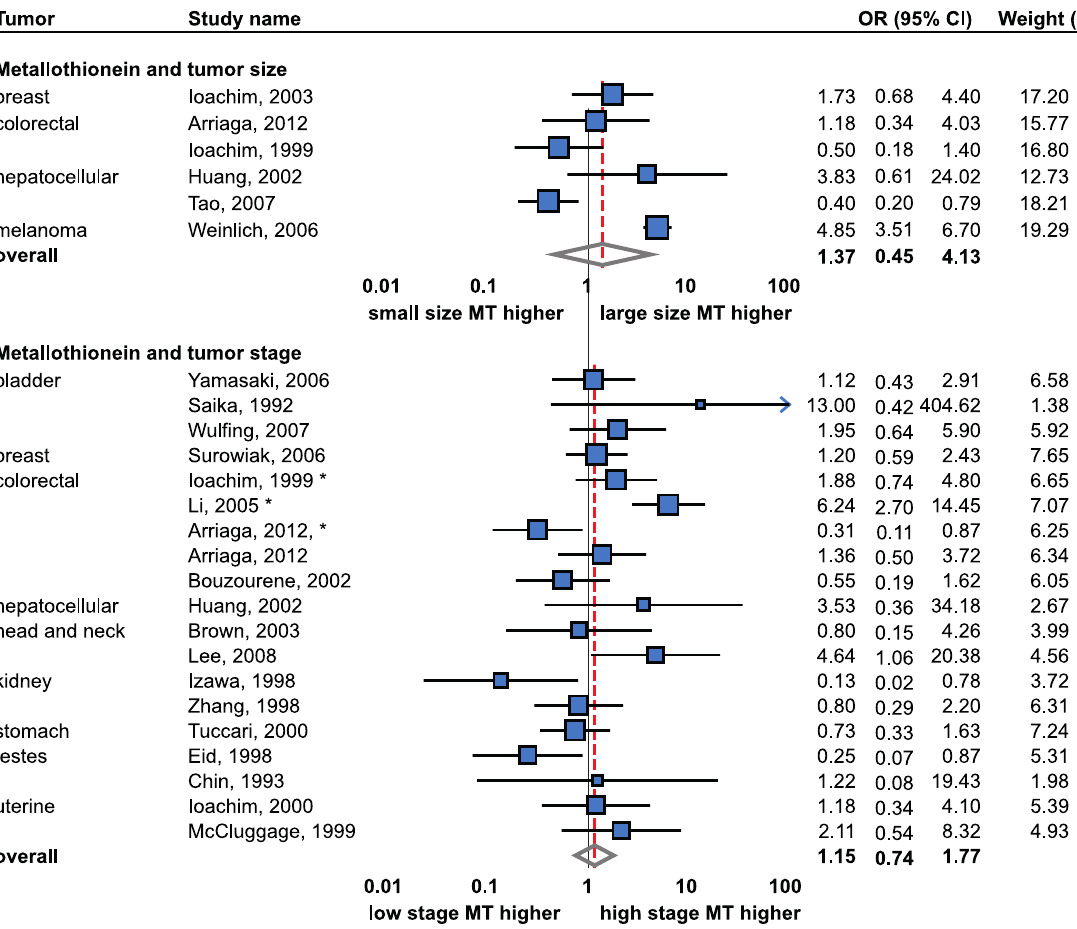
Figure 3. Forrest plot of studies reporting the association of metallothionein staining and tumor size and stage. Random effects model used for both outcomes, Relative weight of individual studies displayed in %. * indicates studies using Dukes staging system. For more detailed results see Table 1 and 2. Sorted alphabetically by tumor types. Forrest plot displayed as odds ratio and 95% confidence intervals. Red dashed line indicates the result for all studies together. OR, odds ratio; CI, confidence interval.